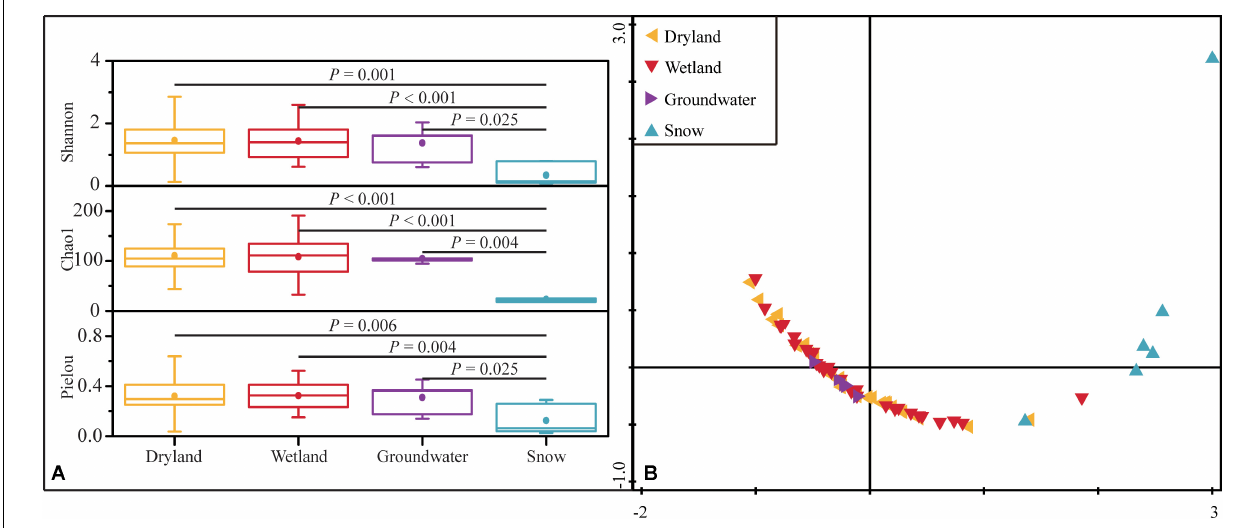
FIGURE 4 | Alpha-diversity represented by Shannon, Chao1 and Pielou indices in the four ecosystems. The P -values indicate differences between groups based on the Mann–Whitney U test (A) , and NMDS analysis of α -diversity based on Euclidean distances of the four diversity indices (Shannon, Simpson, Pielou and Chao1) of the anammox bacterial community (B)